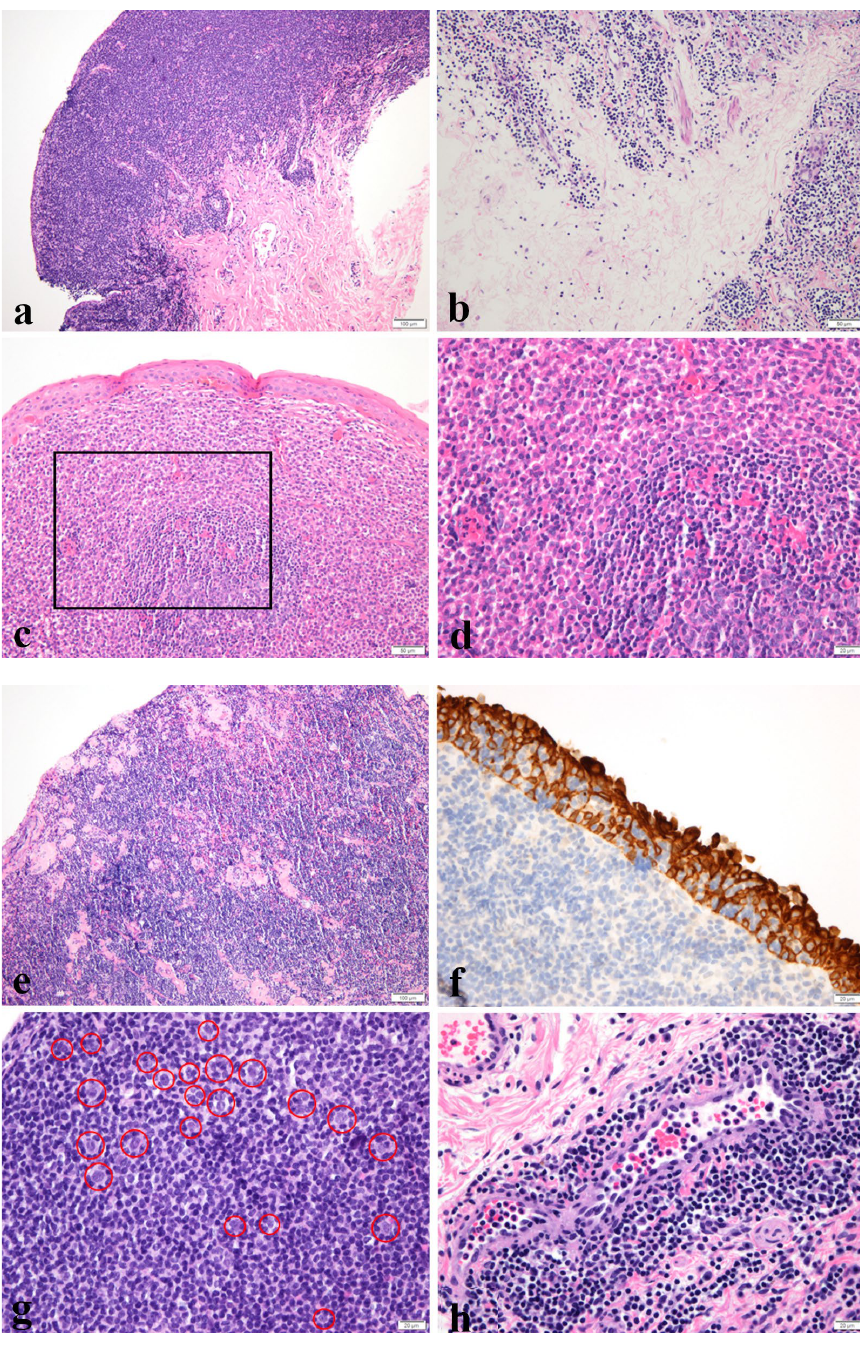
Figure 1. Images show pathological characteristics. ( a ) Neoplastic cells are infiltrating in a confluent pattern. (H&E, ×100), ( b ) Neoplastic cells are infiltrating in a nonconfluent pattern. (H&E, ×200), ( c,d ) Tumor cells are differentiated into sheets of plasma cells. d represents the magnification view of the inlet box of c . (H&E, c ; ×200, d ; 400), ( e ) Multifocal sclerosis is intermixed with neoplastic lymphoid cells. (H&E, ×100), ( f ) Immunohistochemistry staining for CK reveals lymphoepithelial lesion. (CK, ×400) ( g ) Medium-sized lymphoid cells are intermixed with cells transformed into large cells. The large cells are indicated with red circles. (H&E, ×400), ( h ) High power field view shows lymphovascular invasion. (H&E, ×400). H&E, hematoxylin, and eosin; CK, cytokeratin.